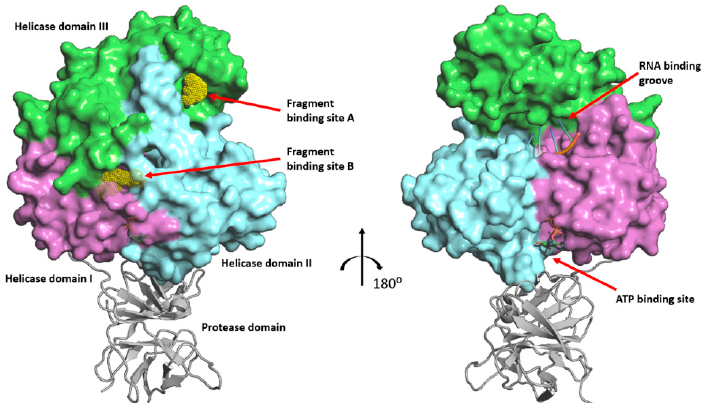
Figure 1. Overall structure (two views related by 180° rotation, black arrow) of ZIKV NS3 protein, including the helicase domains I (magenta surface), II (cyan surface), and III (green surface), as well as the protease domain (grey ribbons). The latter is approximated from the homologous DENV NS3 full-length structure (PDB code 2VBC), which has been superposed on the ZIKV NS3-Hel structure. The binding positions of RNA and ATP are also shown. The fragment-binding sites, A and B, discovered here, are indicated using the ball representation for fragments 1 and 3 , respectively.